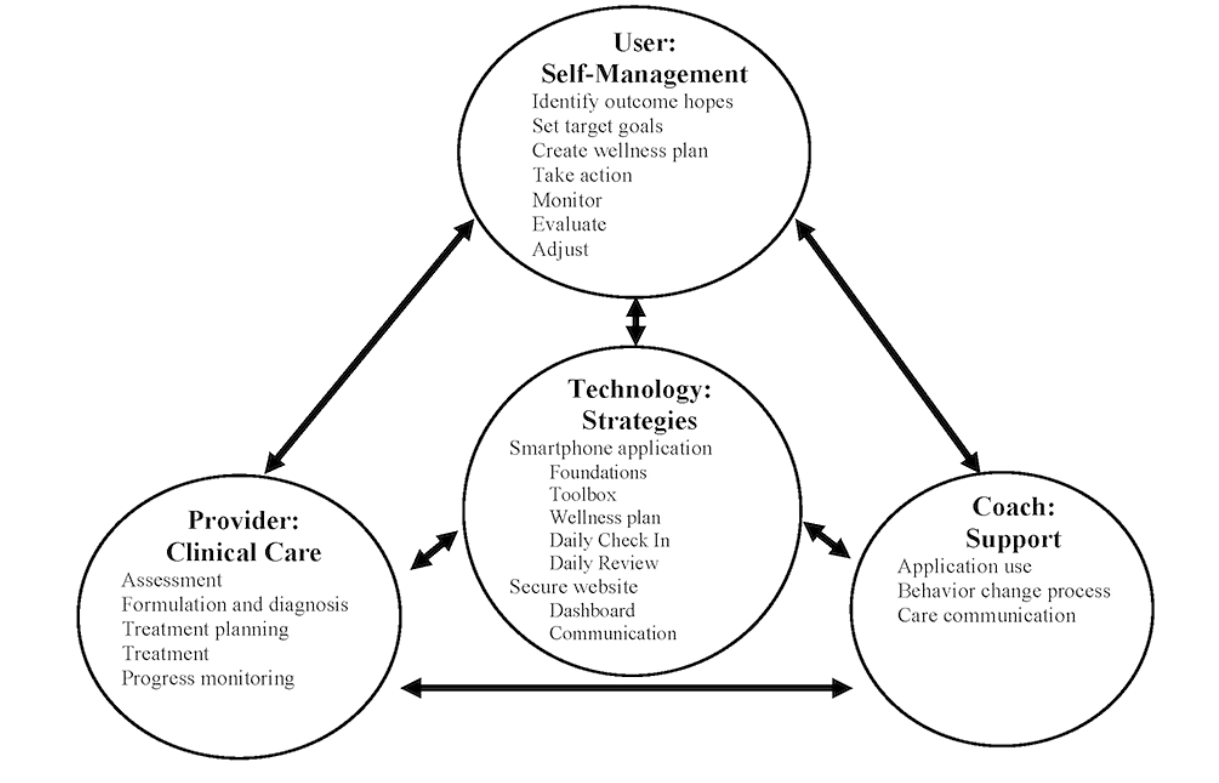
Figure 1. LiveWell division of